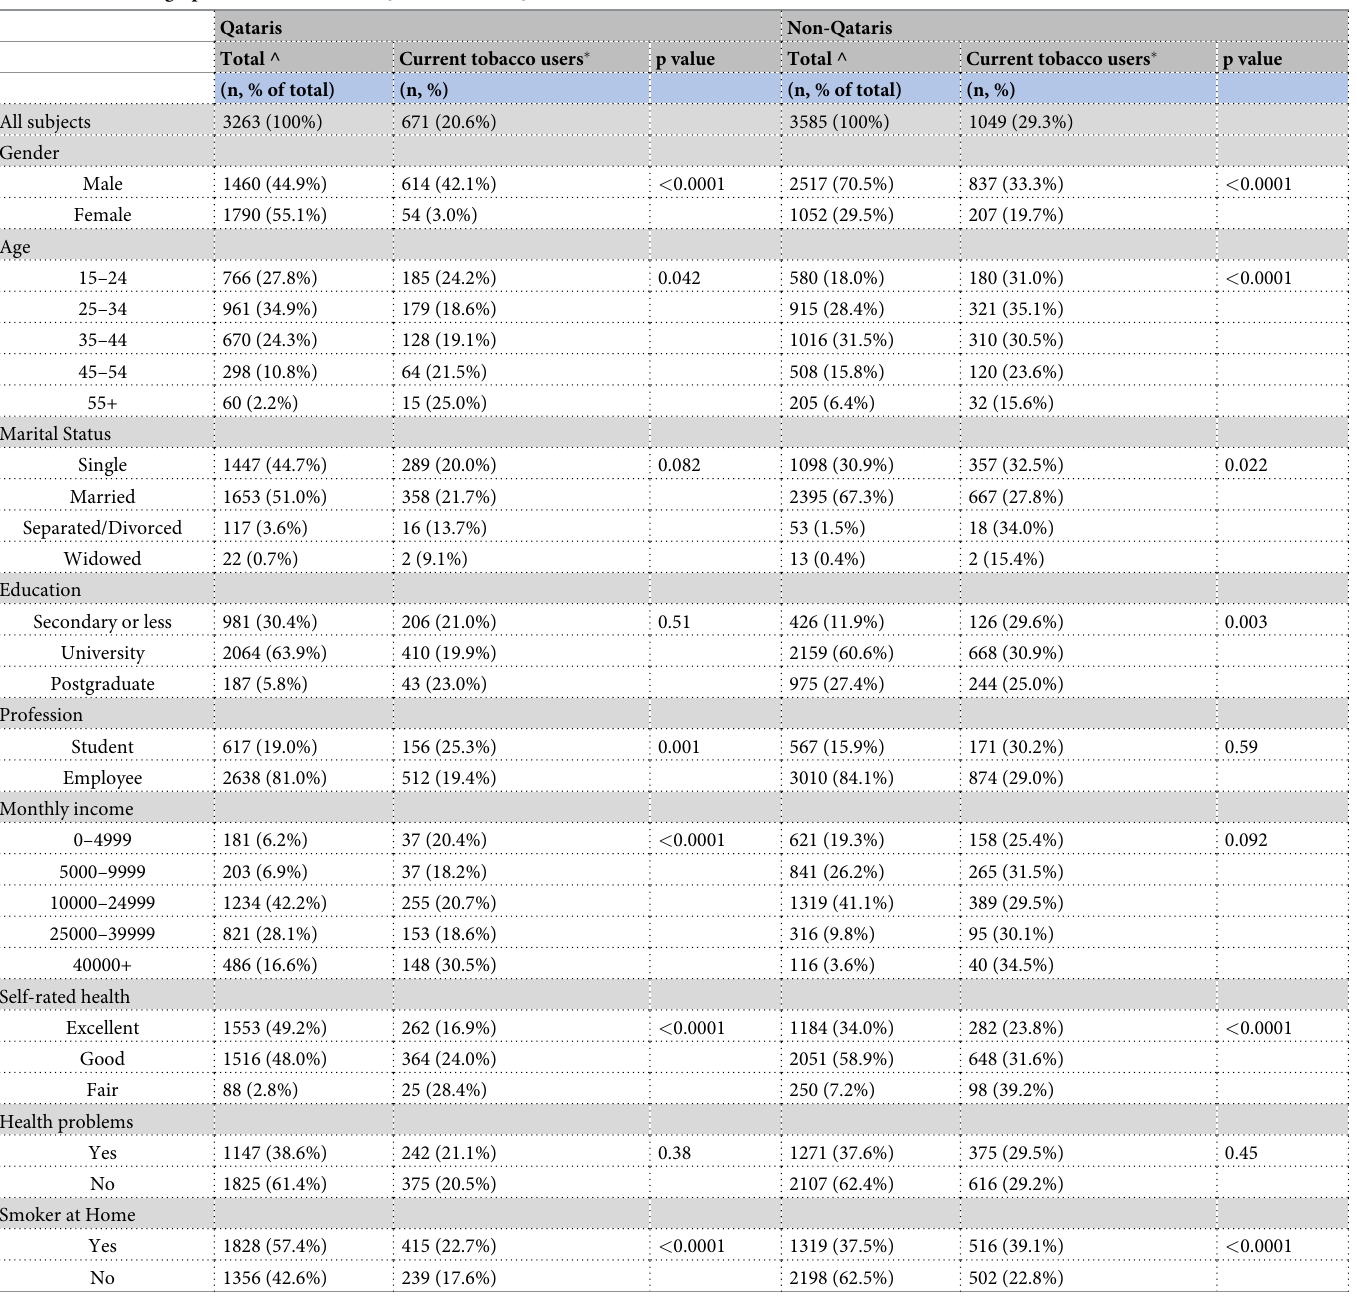
Table 2. Sociodemographic characteristics of Qatari and non-Qatari current tobacco